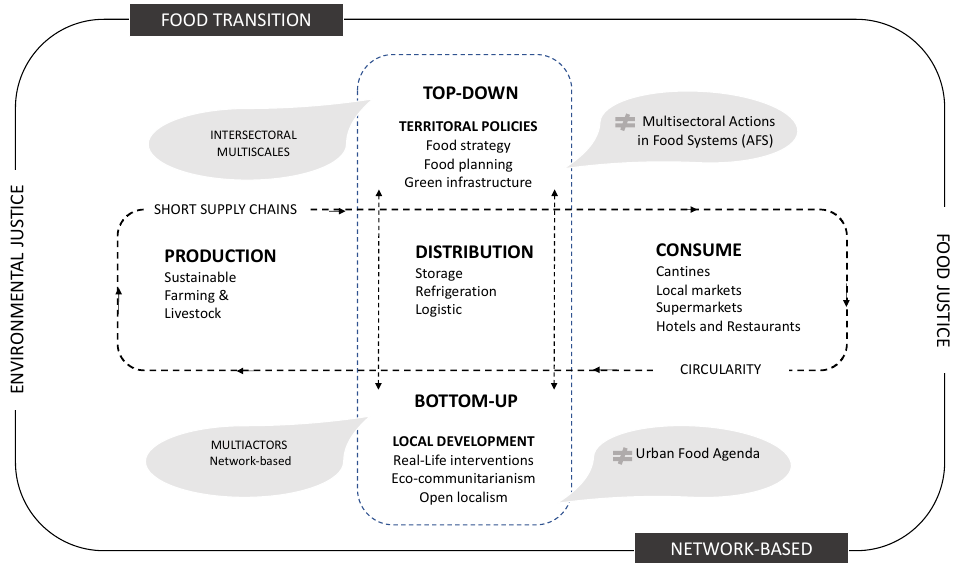
Figure 4. Conceptual model for food strategy definition and implementation in the LMA.